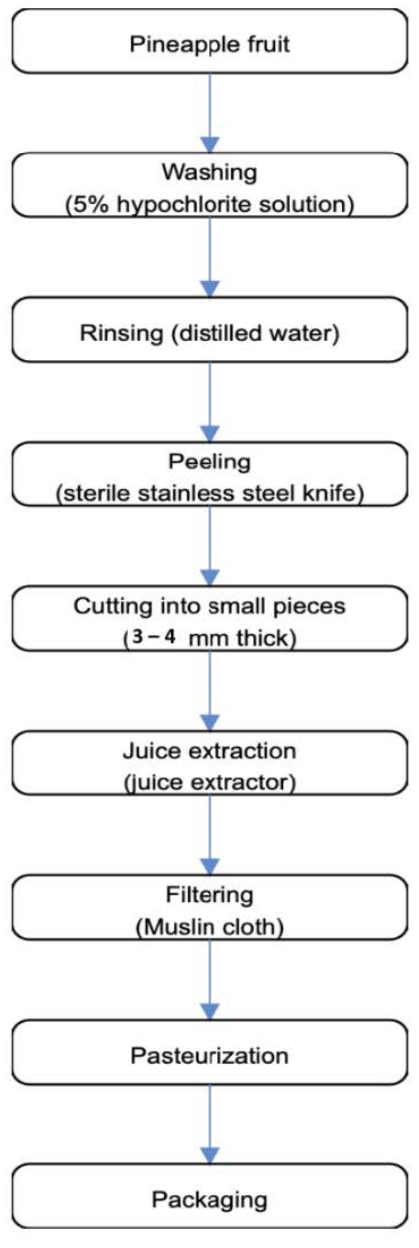
Figure 2. The preparation of pineapple fruit juice (Okwori et al., [28]).